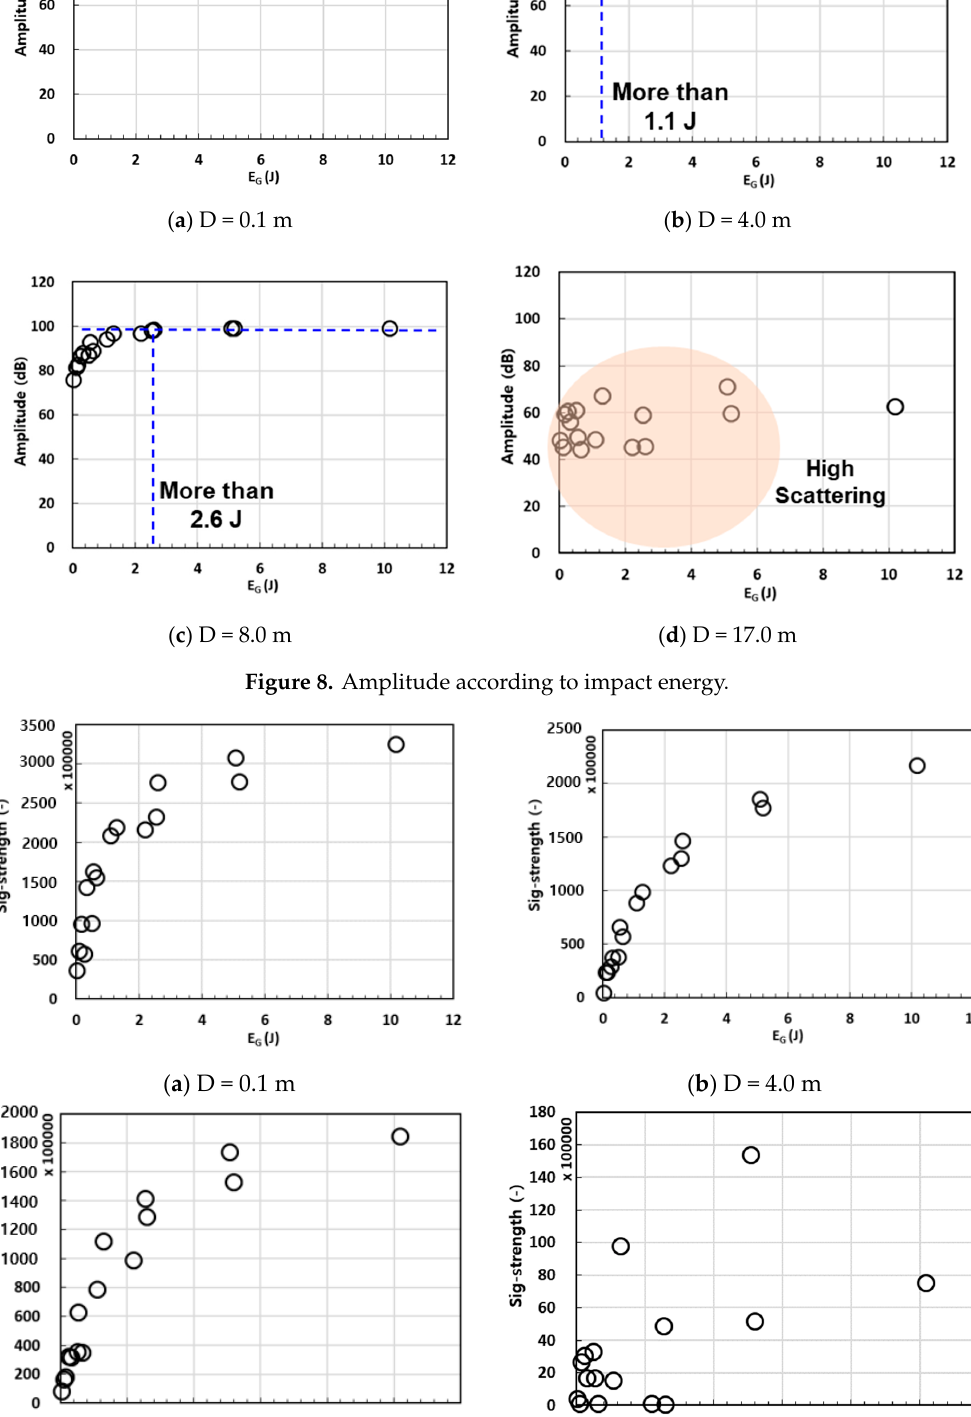
Figure 9. Signal strength according to impact energy.